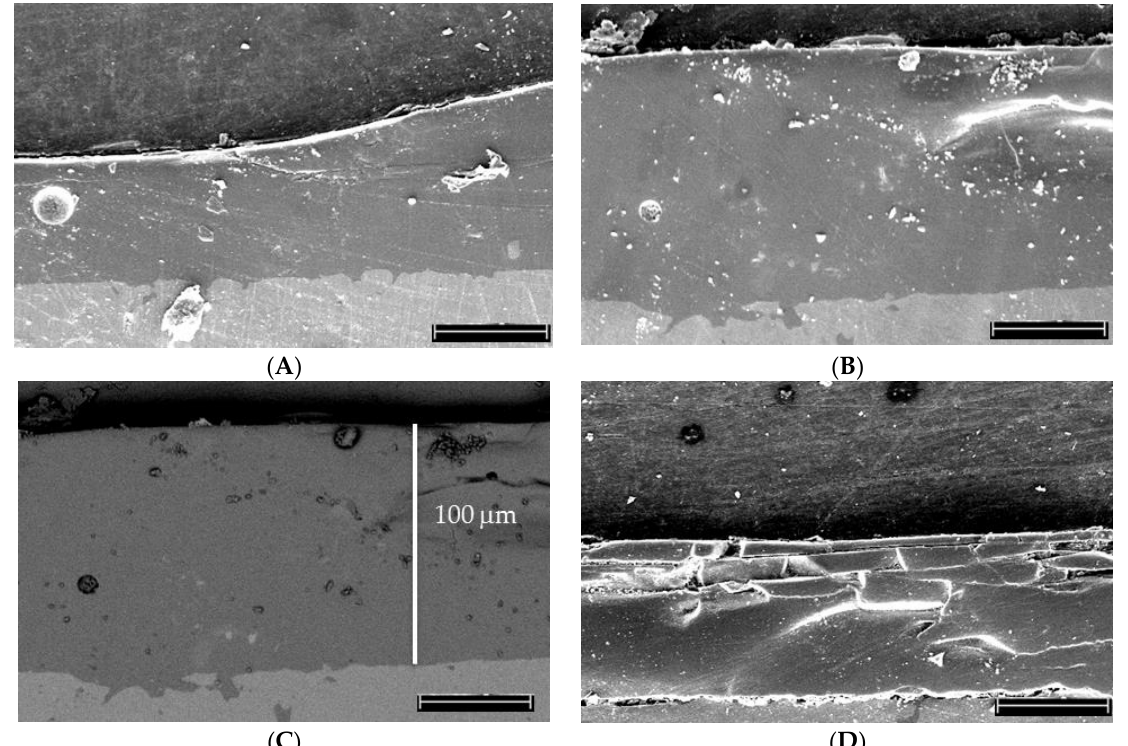
Figure 14. Micrographics of samples sintered and enameled in one step at different temperatures ( A ) 835, ( B ) 850, ( C ) 850 (in BSE—backscattered electrons ) and ( D ) 900 °C (magnification bars are 50 μm).